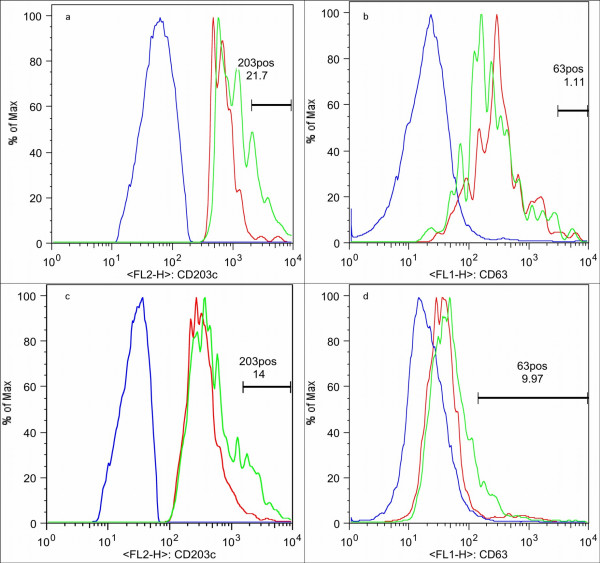
Histograms of CD63 and CD203c expression on basophils and control cells. Histograms of expression of CD203c (a & c) and CD63 (b & d) on basophils at baseline (red line) and after maximal stimulation (green line), and on lymphocytes (blue line) after lysis with Immunoprep/Q-prep (a & b) and WBL (c & d). Markers were set to include ~2% of unstimulated basophils.